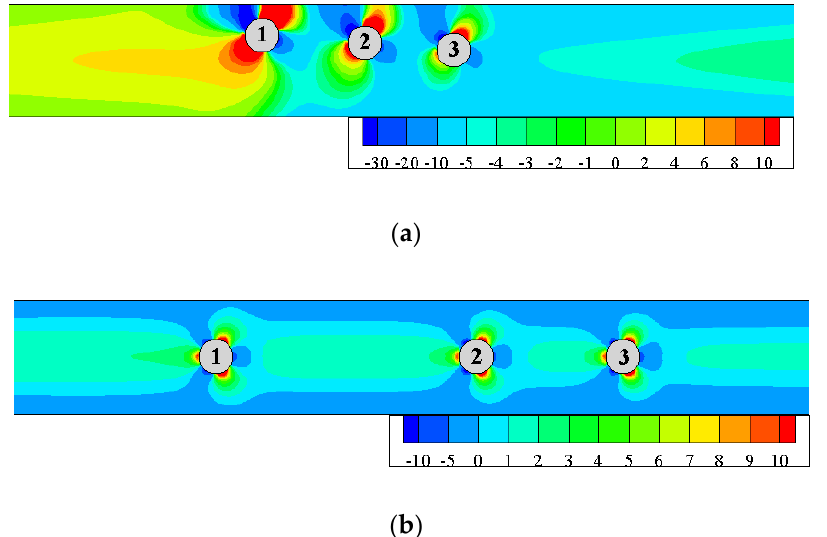
Figure 6. Pressure contours of different times for the three particles. ( Wi = 0.5, α = 0.1, η r = 0.3, ε = 0.3, y 0 = 0.2). ( a ) t = 4; ( b ) t = 60.